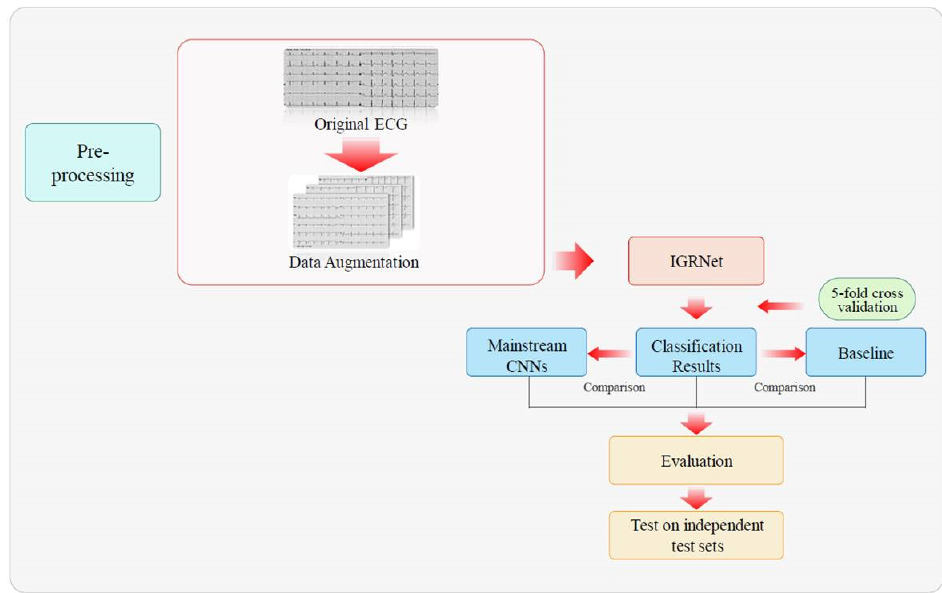
Figure 2. The workflow of prediabetes diagnosis.